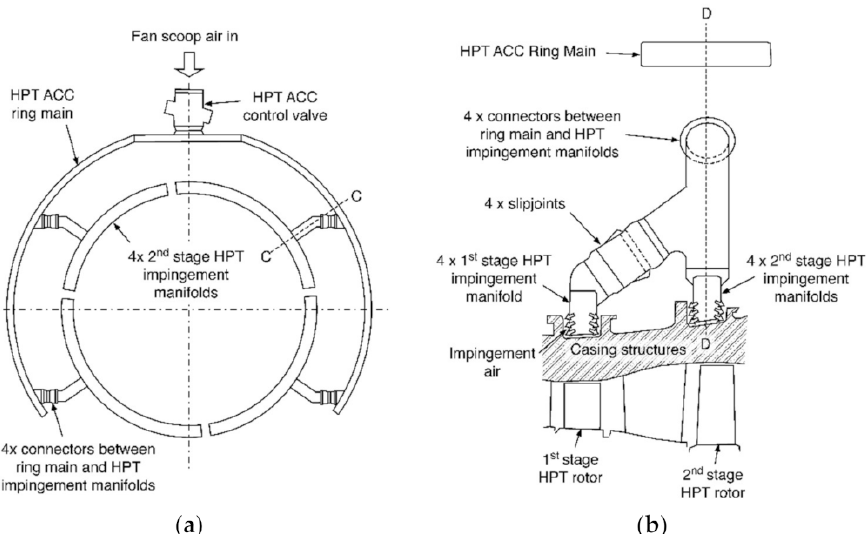
Figure 3. ( a ) Axial plane through the HPT ACC multiple-entry feed system developed as part of the NASA Energy Efficient Engine (E 3 ) program. Figure adapted from [7]. Position of axial plane is shown in ( b ) (D-D). ( b ) Meridional plane through the HPT ACC system developed as part of the NASA Energy Efficient Engine (E 3 ) program. Figure adapted from [7]. Position of meridional plane is shown in ( a )